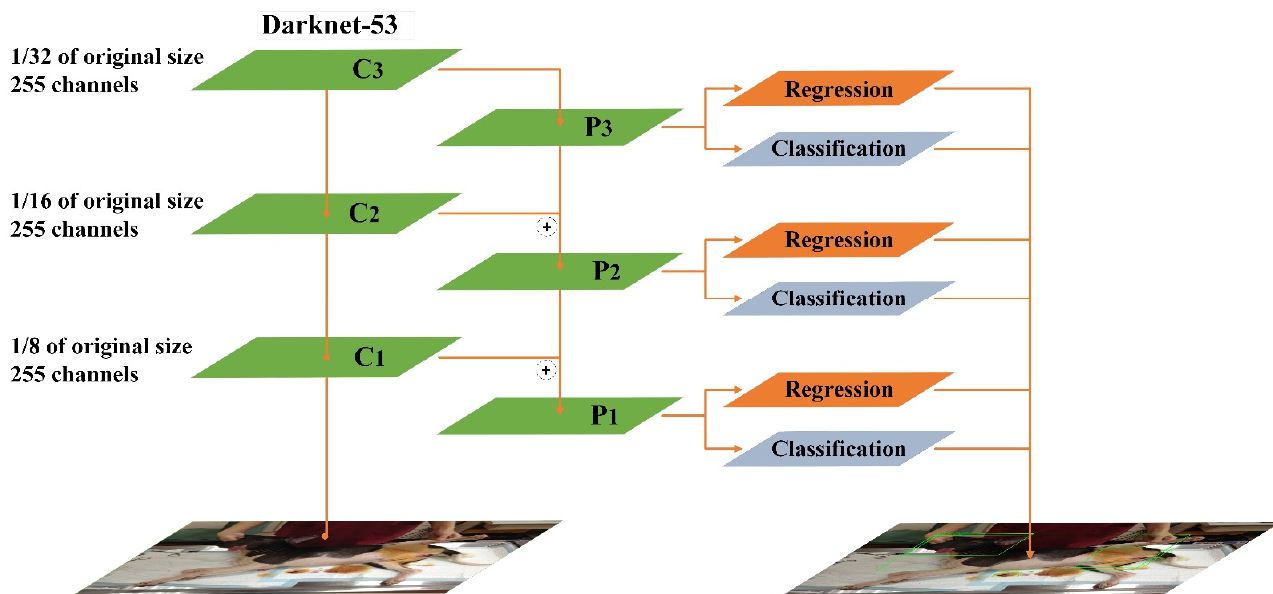
Figure 1. Structure of YOLOv3 [26] C1–C3 refer to the feature layers of the last three scale. P1–P3 (After superimposition of adjacent layers through upper sampling). ⊕ refers (The superimposition Operation).